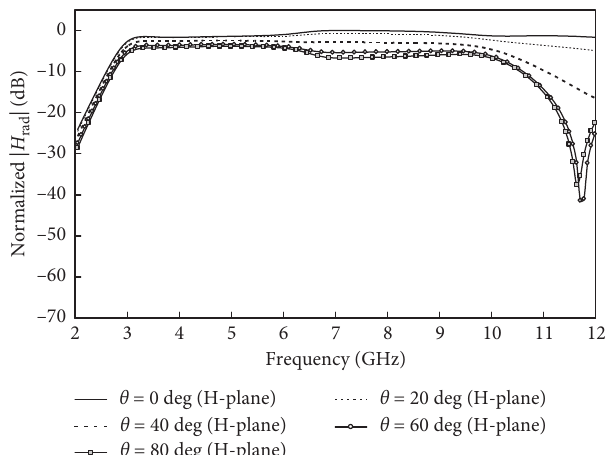
Figure 16: Simulated | H rad | of the antenna at various positions on H-plane in the right or left